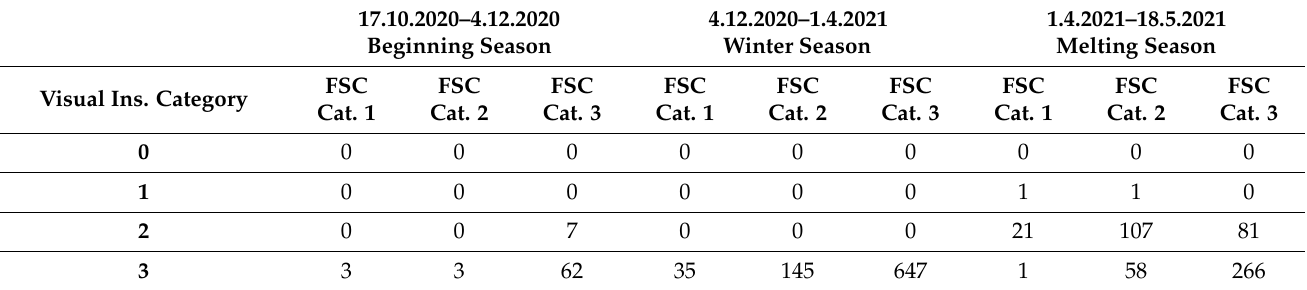
Table 2. The correspondence between visual inspection of snow presence and FSC data in Sodankylä (ROI the whole snowbed).